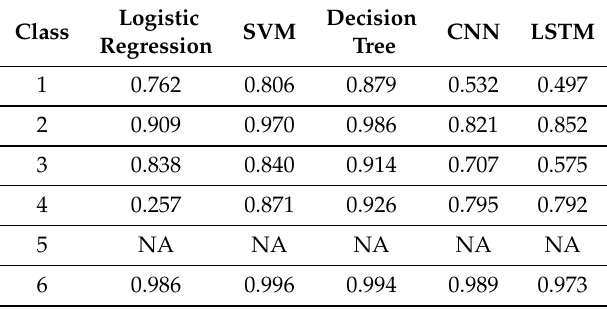
Table 10. Classifier precision results.